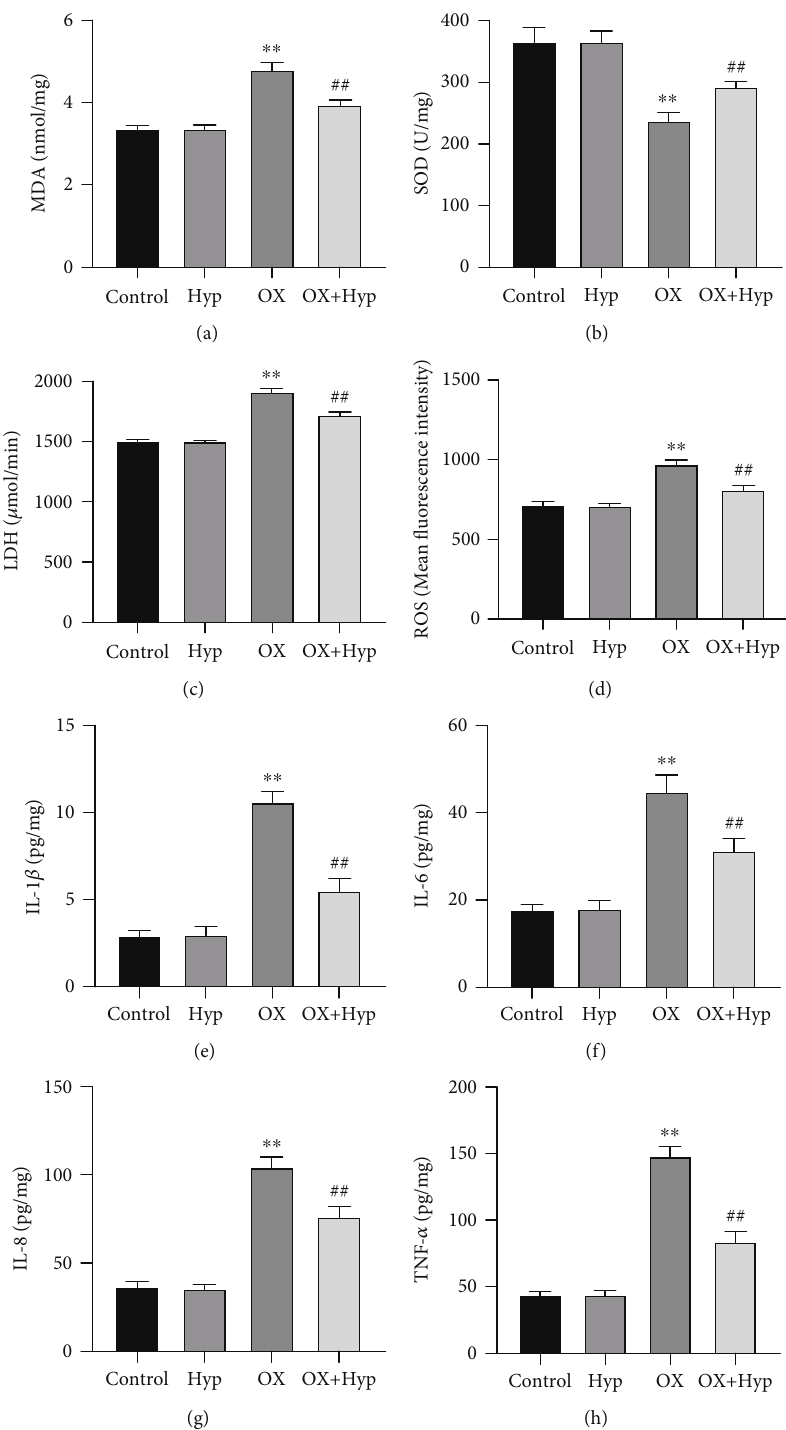
Figure 5: E ff ect of hyperoside on oxidative stress and in fl ammatory response in calcium oxalate-treated HK-2 cells. (a – d) Biochemical tests for MDA (a), SOD (b), LDH (c), and ROS (d) levels in cells; (e – h) ELISA detection of IL-1 β (e), IL-6 (f), IL-8 (g), and TNF- α (h) levels in cells, ∗∗ P < 0 : 01 vs. control group and ## P < 0 : 01 vs. OX group. MDA: malondialdehyde; SOD: superoxide dismutase; LDH: lactate dehydrogenase; ROS: reactive oxygen